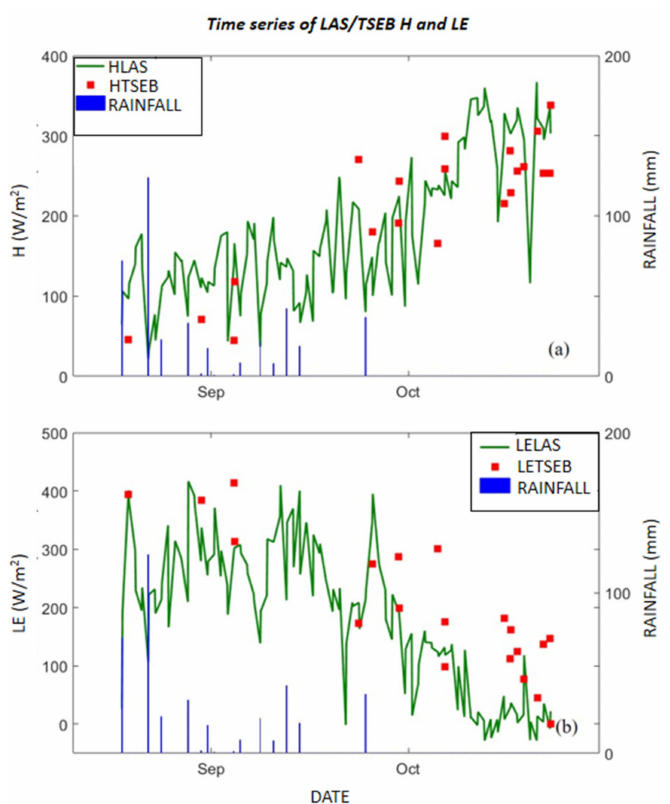
Figure 10. Time series of the comparison between the LAS grid scale measurements (H LAS and LE LAS ) and TSEB predictions based on MODIS products (Hsim and LEsim) for footprint weighted method (at MODIS overpass